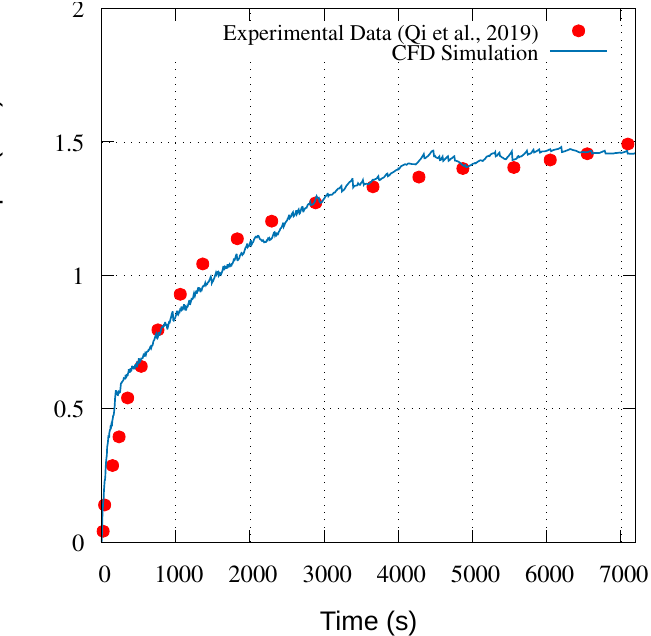
Figure 1. Results of the model validation for scour around a pile group caused by a combined wave–current effect Qi et al. [33].